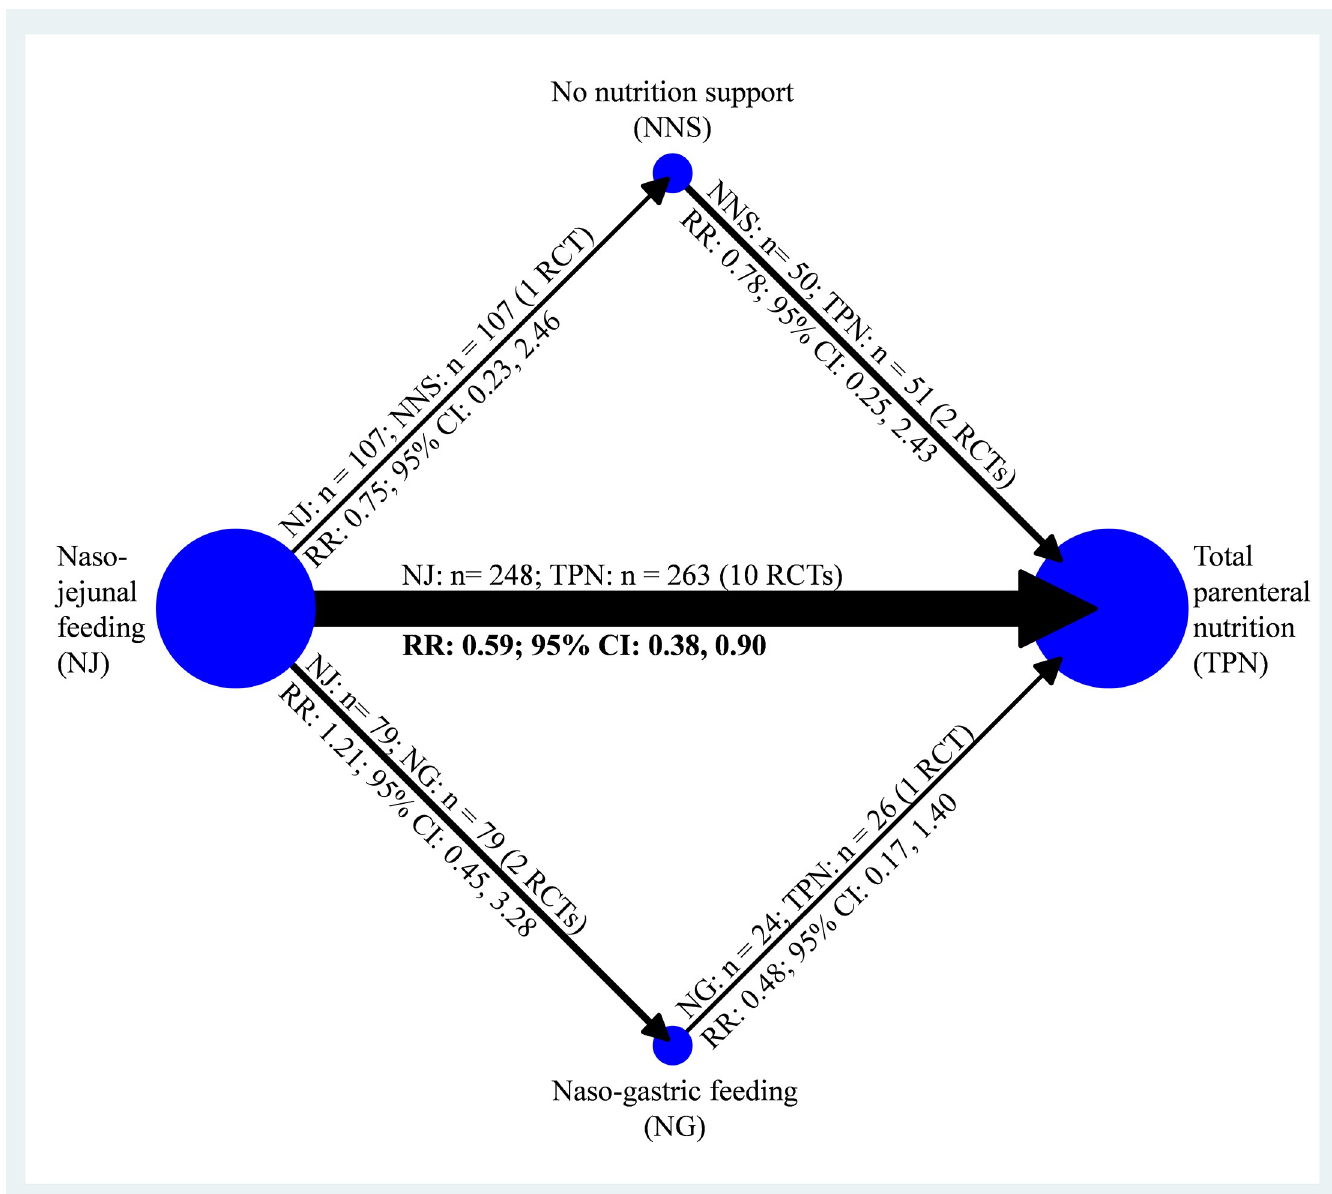
Fig 2. Network geometry of total number of infectious patients among nutritional therapies and no nutritional